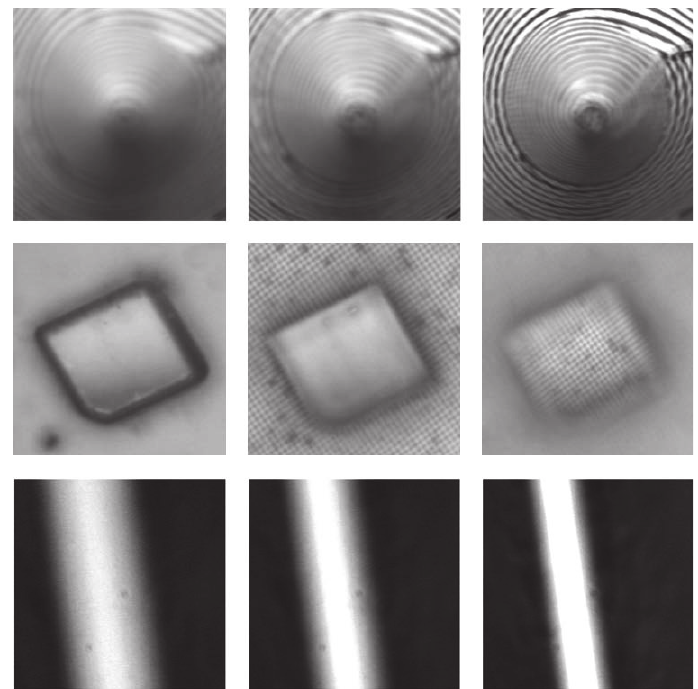
Figure 7. Sample images from the sequence of real objects: real cone (first row), micro sheet (second row), groove